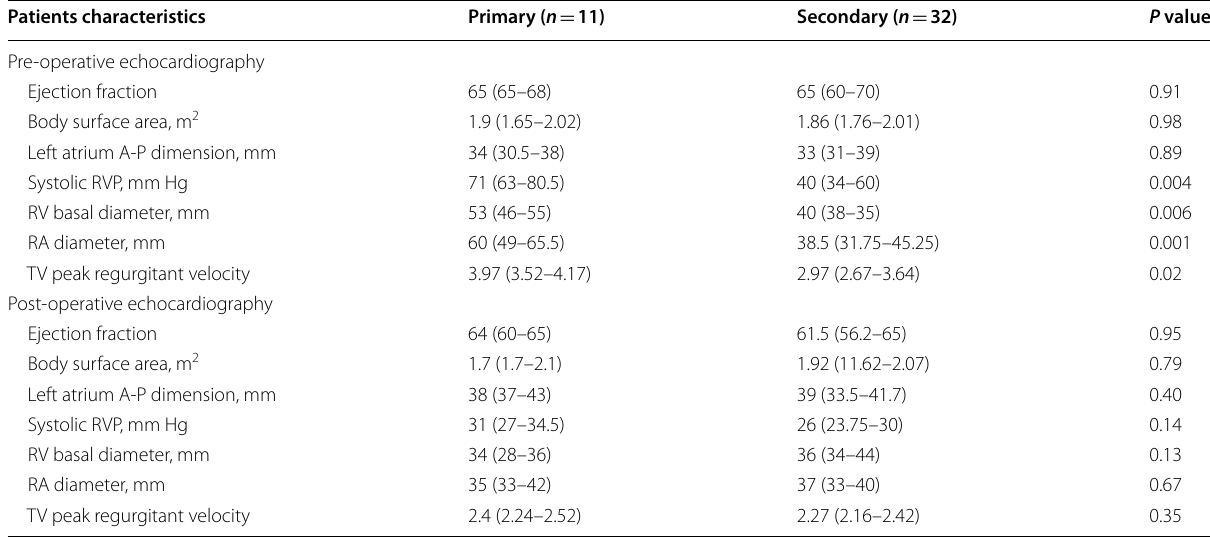
A-P Lung transplant surgery: anterio-posterior, RVP Right ventricular pressure, RV Right ventricle, RA Right atrium, TV Tricuspid valve